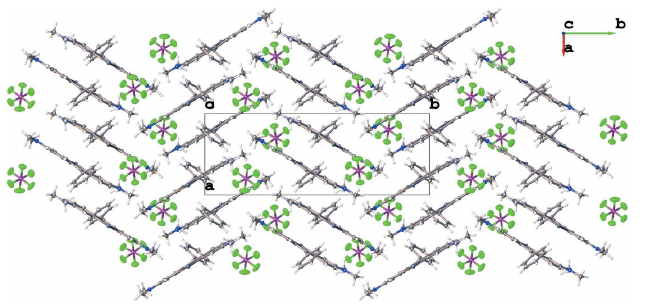
Figure 2 Crystal packing of the title compound viewed along